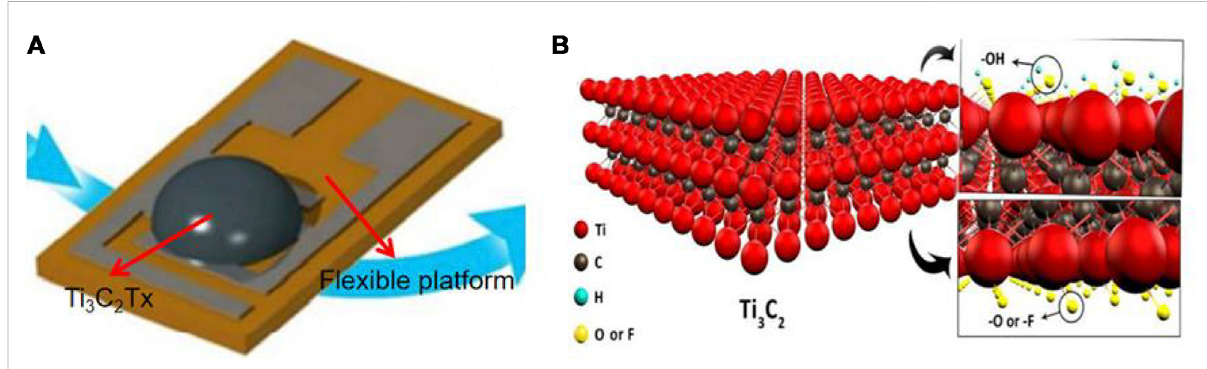
FIGURE 1 (A) Solid solution pouring method to prepare the sensor. (B) Ti3C2Tx structure and surface functional groups (adapted from Lee et al., 2017).